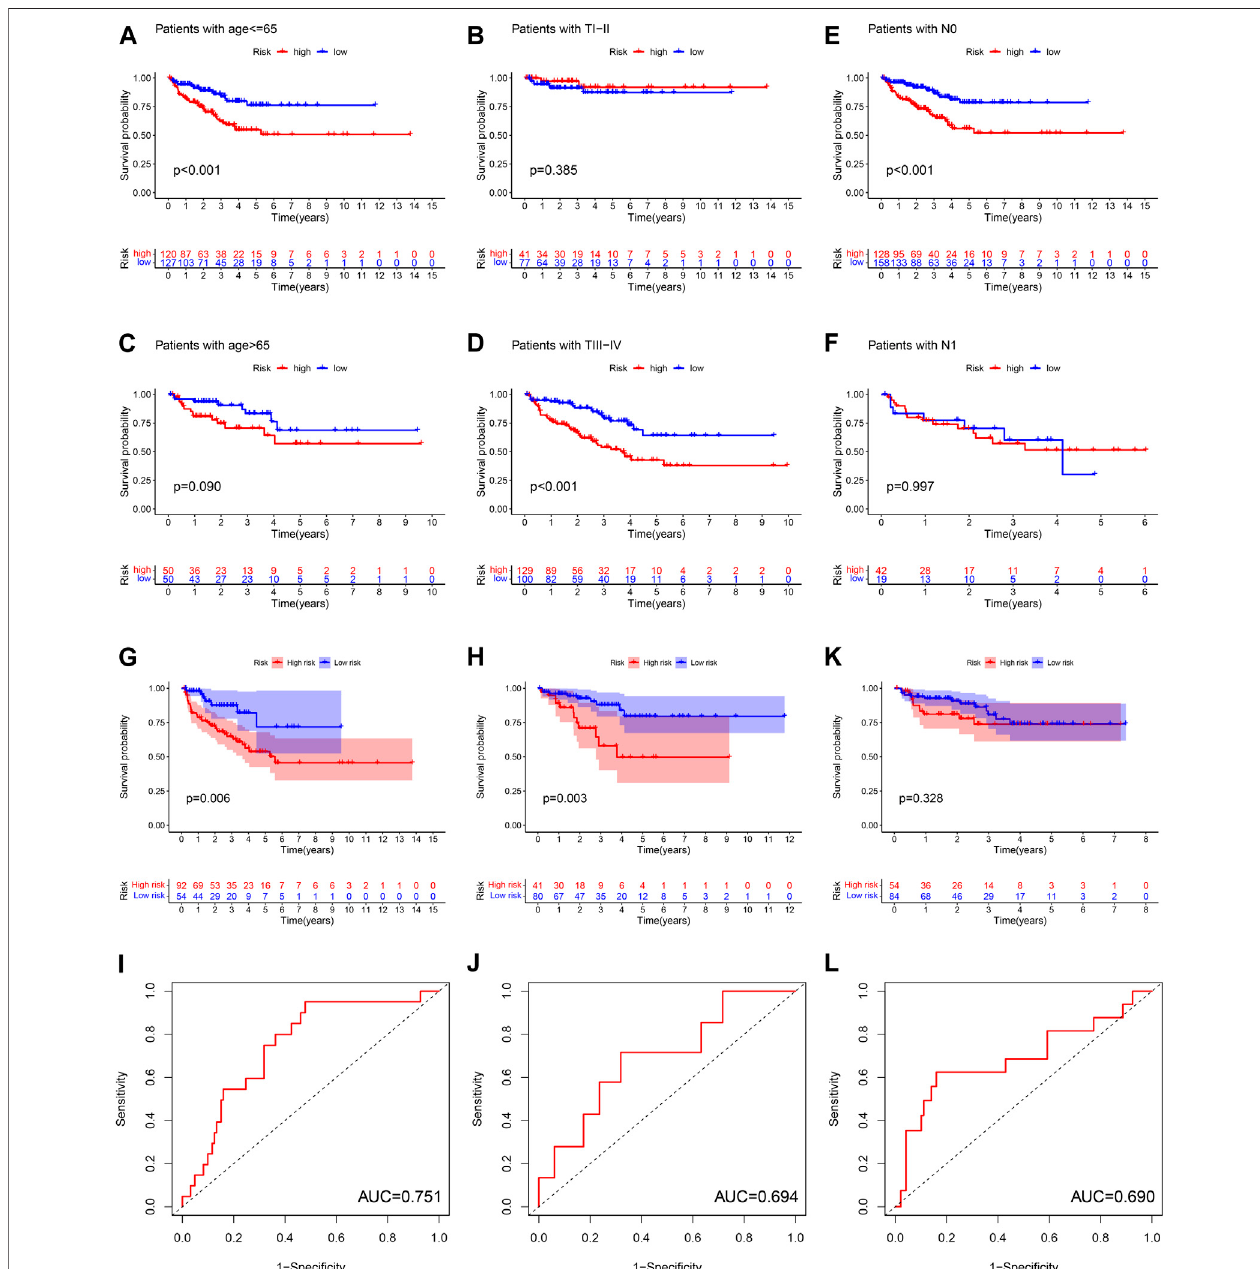
FIGURE7 | The subgroup survivalanalysisbetween high and low riskgroup inpatientsofage ≤ 65 (A) , age > 65 (B) , Tstage I-II (C) , Tstage III-IV (D) , N0stage (E) , N1 stage (F) . The survival analysis between high and low risk group, and corresponding area under ROC curve in cluster 1 cohort (G,H) , cluster 2 cohort (I,J) , cluster 3 cohort (K,L)